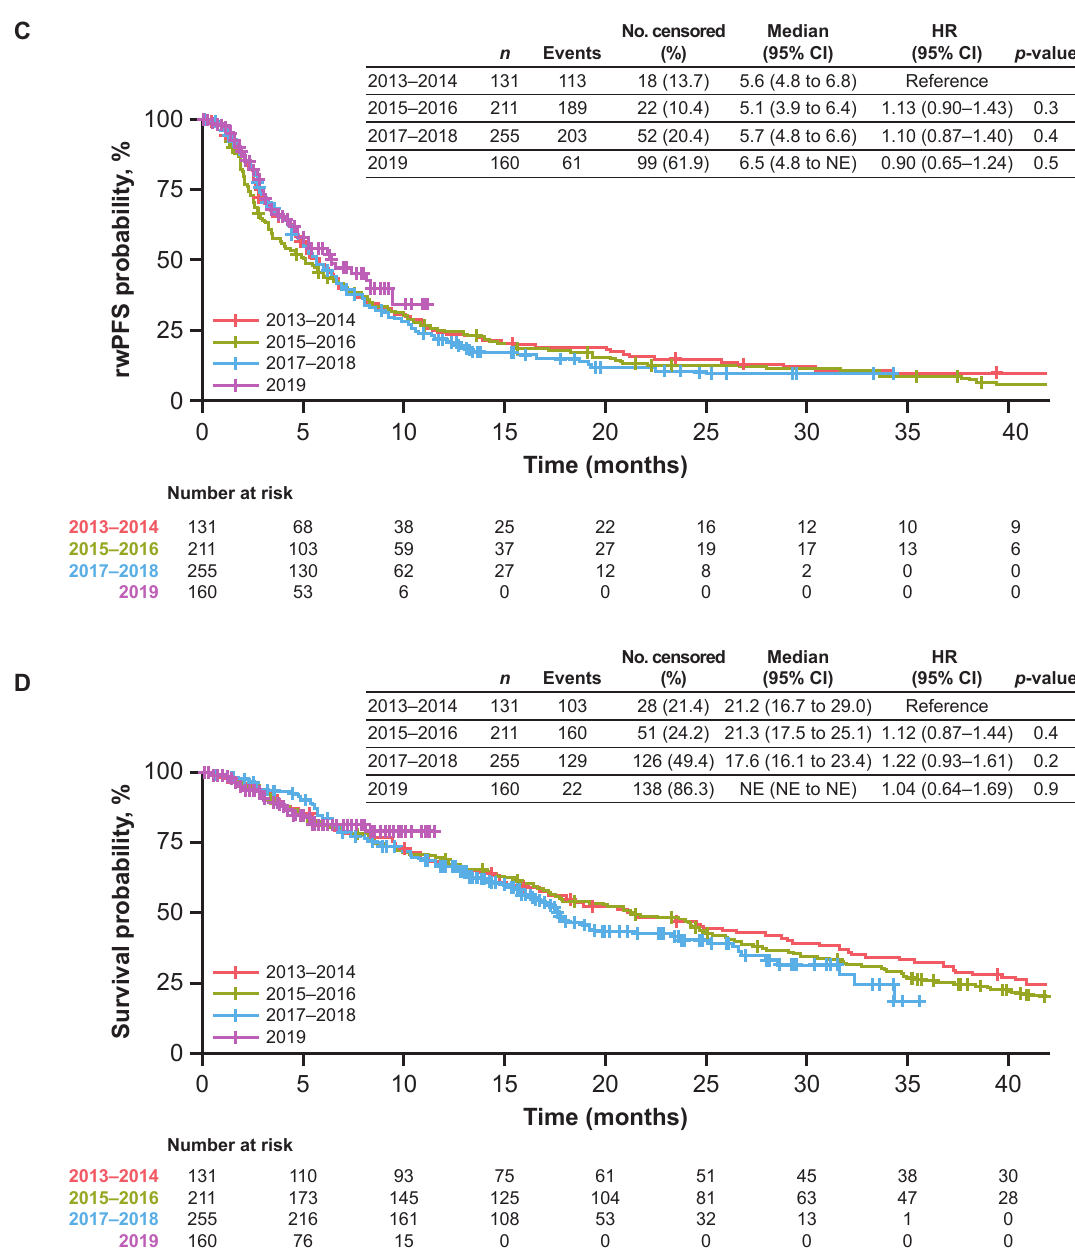
Figure 2. Effectiveness of T-DM1 in patients who initiated T-DM1 in any treatment line. ( A ) TTNT or death; ( B ) TTLA of T-DM1 before discontinuation or death; ( C ) rwPFS; and ( D ) OS.CI = confidence interval; NE = not estimable; No = number; OS = overall survival; rwPFS = real-world progression- free survival; T-DM1 = trastuzumab emtansine; TTLA = time to last administration; TTNT = time to next relevant